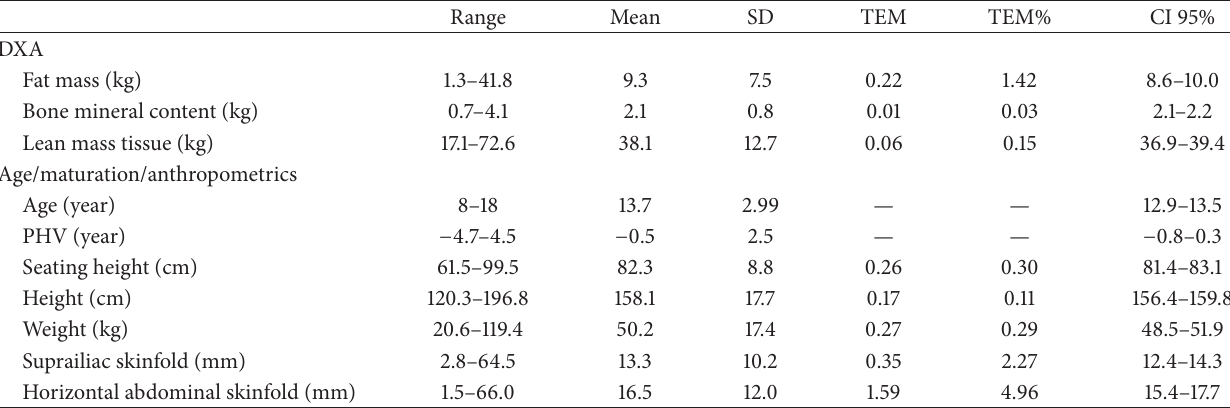
Table 1: Descriptive statistics of body composition in boys ( 𝑛 = 408 ), including absolute and relative TEM of the dependent (DXA) and independent measures (maturation, body size, and